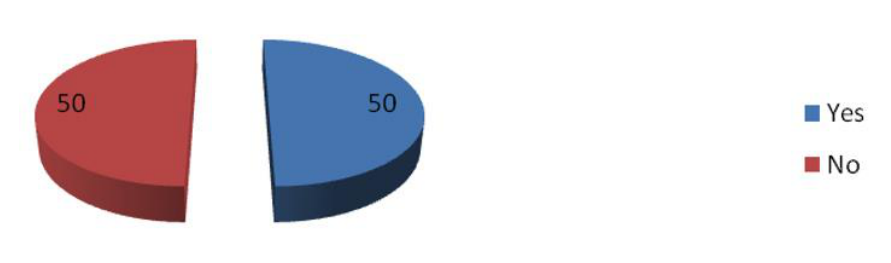
Figure 7: Management take capacity building as a priority